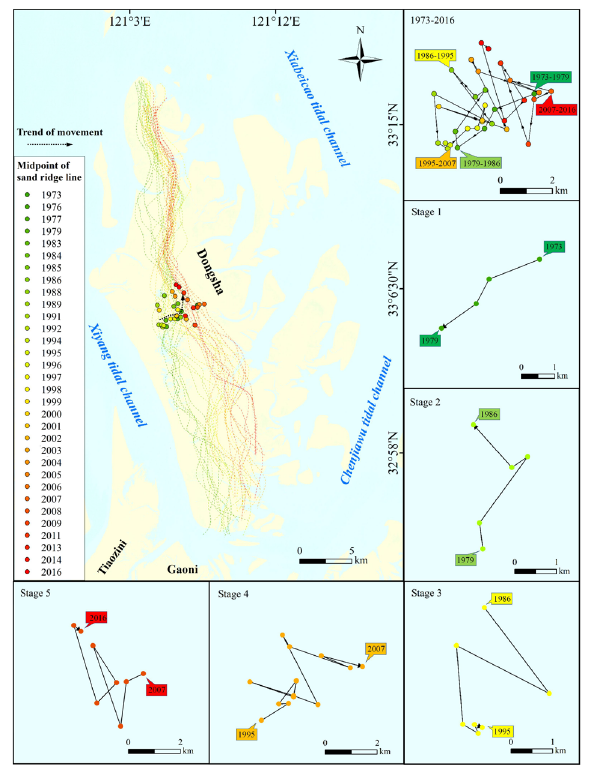
Figure 6. Changes in the midpoint of the sand ridgeline of Dongsha Shoal during